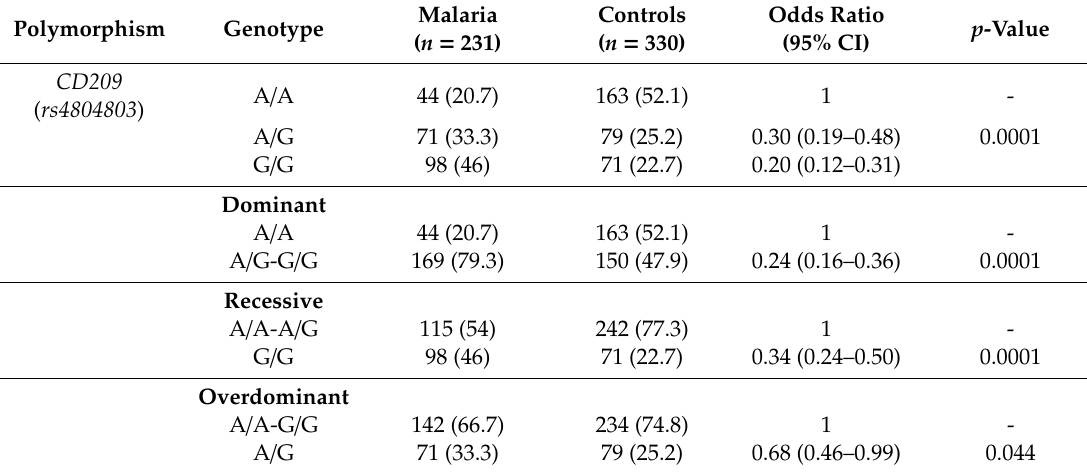
Table 3. Genotypic frequency of the CD209 gene promoter polymorphism between malaria-infected and control